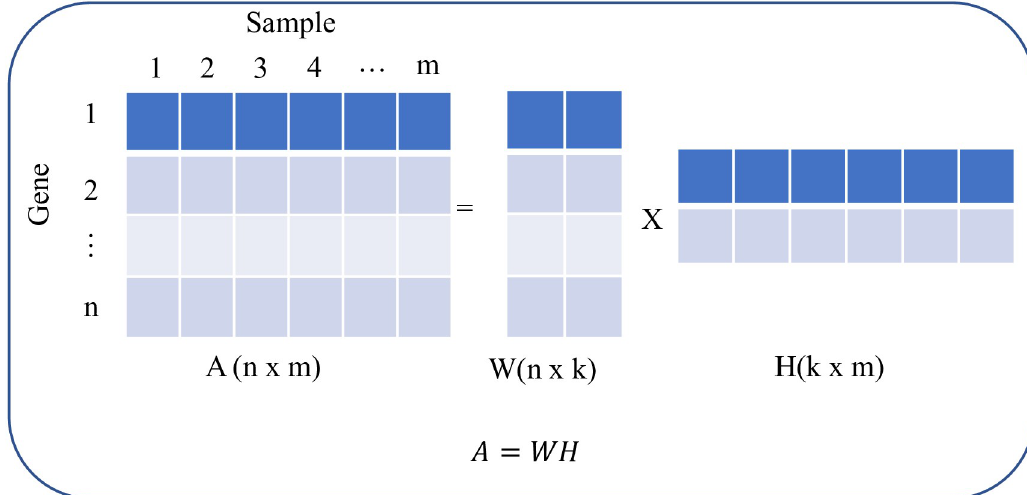
Fig 2. Non-negative matrix factorization